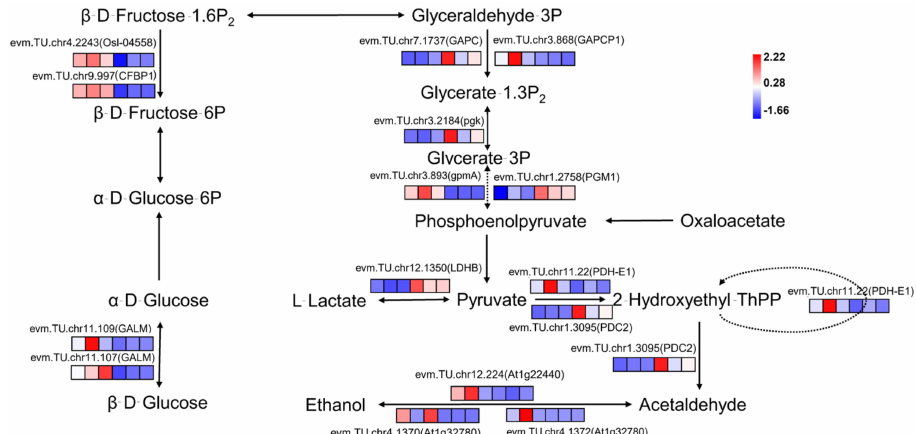
Figure 5. Schematic diagram of DEGs in the glycolysis/gluconeogenesis pathway of haploid ginkgo. The three squares on the left of the gene expression heatmap represent haploid ginkgo, and the three squares on the right represent diploid ginkgo.